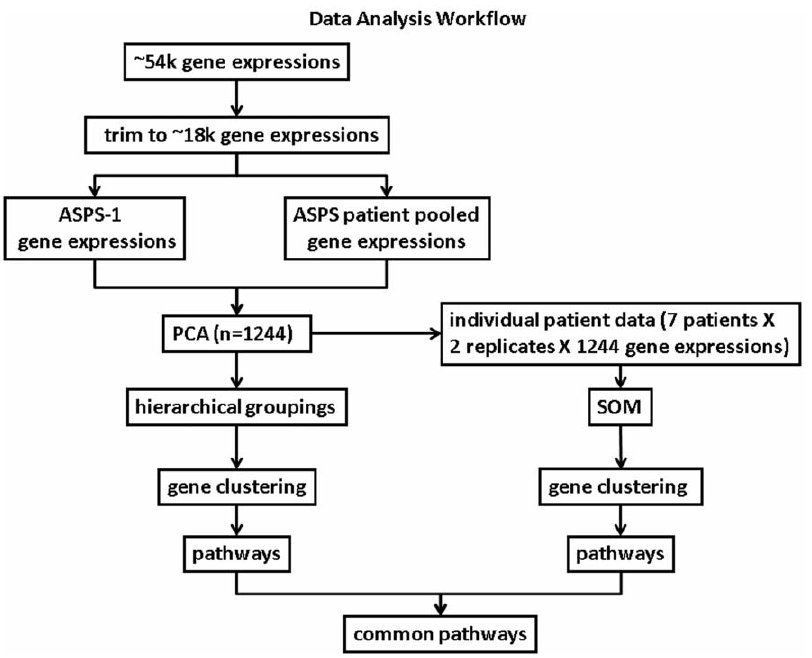
Figure 1. Data Analysis Workflow. The expression of 54,675 genes, done in duplicate, was measured for ASPS tissue biopsies and the ASPS-1 tumor cell. Selecting only present (P) calls trimmed this starting set to 17,698 gene expressions. Next, these , 18 k candidate genes were analyzed using Principal Component Analysis (PCA). PCA identified 1244 genes that distinguished the pooled patient data from the ASPS-1 tumor cell data. From this point forward these 1244 genes were analyzed, in parallel, for the pooled patient/ASPS-1 tumor cell data (left-most path), and the individual patient gene expressions (right-most path). The left-most path used conventional hierarchical clustering to identify gene clusters. Clustered genes were then used to reveal a set of ASPS-specific pathways. The right-most path analyzed the individual patient measures of these same 1244 gene expressions, using self-organizing maps (SOMs), to cluster genes according to similarities in gene expressions across patient samples. These gene clusters were also analyzed to identify their set of ASPS-specific pathways. The final step in this process selected only pathways and their constituent genes that are shared amongst the ASPS-specific pathways identified from each parallel analyses.